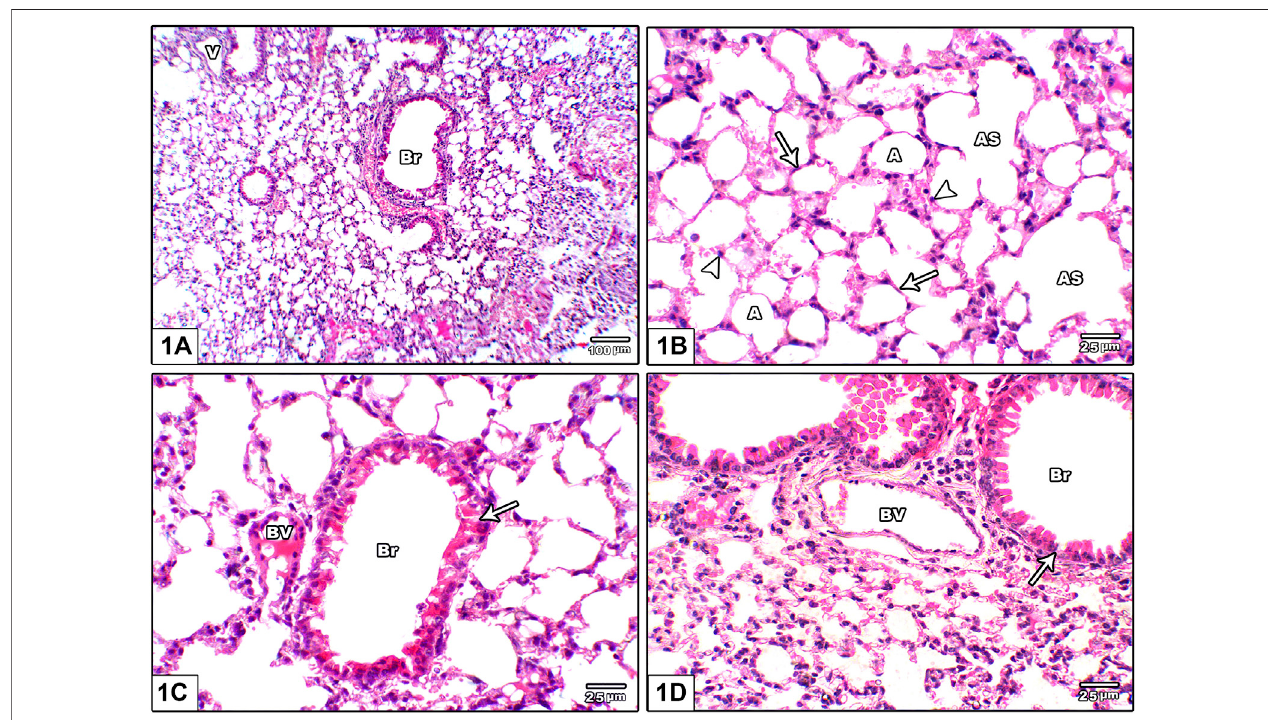
FIGURE 1 | Photomicrograph of H&E stained lung from the vehicle control group (A) An image shows normal lung architecture with thin alveolar septa, normal bronchioles (Br) and normal blood vessels (V) (B) An image shows patent alveoli (A) with thin walls open into alveolar sacs (AS). The alveoli are lined by fl attened pneumocytetype Icellswith fl at nuclei(arrow) and domeshaped pneumocytetypeIIwithcentral rounded nuclei(headarrow) (C) and (D) :Imagesshowbronchioles(Br) lined by intact folded respiratory epithelium with thin spiral layer of smooth muscle around it (arrow), note the juxtaposition of pulmonary blood vessels to bronchioles